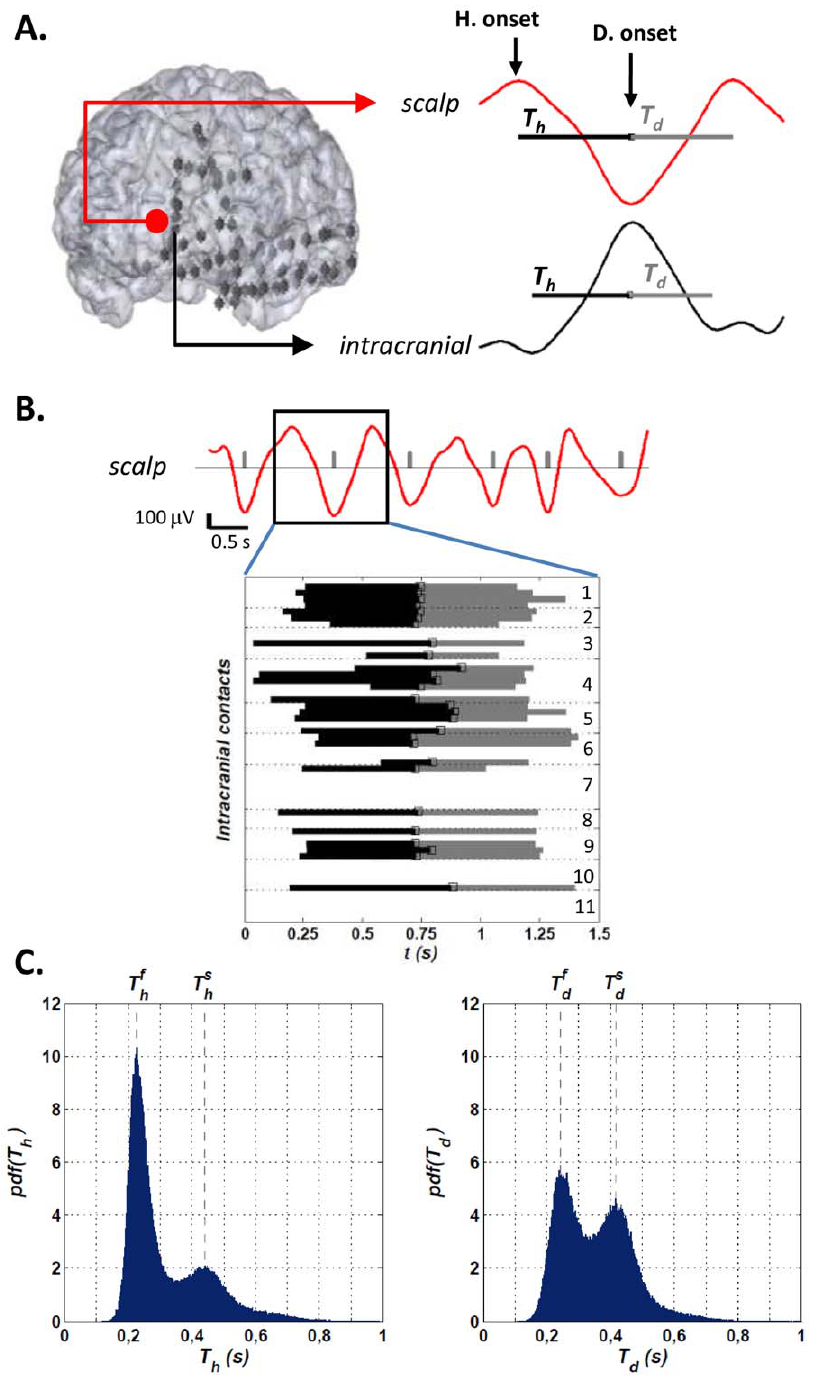
Figure 1. Illustration of the slow wave events detection method and example of T h /T d distributions. A. Left : 3D reconstructed implantation of one subject. The red circle marks the approximate position of the scalp reference contact. Right : Example of scalp slow oscillation and one of its intracranial correlates (note the polarity inversion of the intracranial signal with respect to scalp). All signals are filtered in the band 0.1– 4.0 Hz. The hyperpolarization and depolarization onsets have been marked for the scalp signal. The duration of the hyperpolarization (T h ) and depolarization (T d ) phases of each oscillation is shown as well (black and gray horizontal lines, respectively). B. Segment of scalp signal presenting six detected slow waves. For the second detection, the T h and T d of the detected intracranial correlates have been plotted. The numbers stand for contacts of the same electrode. This particular implantation consisted of 55 contacts distributed in 11 electrodes, 6 electrodes (n.1–6, 30 contacts) in the left frontal lobe and 5 (n.7–11, 25 contacts) in the left temporal lobe. The contacts in the frontal lobe cover from the F1, F2 and orbital regions to interior regions like the anterior part of the cingulated gyrus, the insula and the cortex subcallosum. The electrodes in the temporal lobe cover different cortical and white matter regions as well as deeper structures like the amygdala and the hippocampus. C. Examples of typical Probability Density Functions of T h and T d obtained for a single subject. For the construction of the pdfs only the intracranially measured T h and T d were taken mark the position of the fast/slow hyperpolarization/depolarization times of the subject. into account. T f = s h = d doi:10.1371/journal.pone.0030757.g001 PLoS ONE |